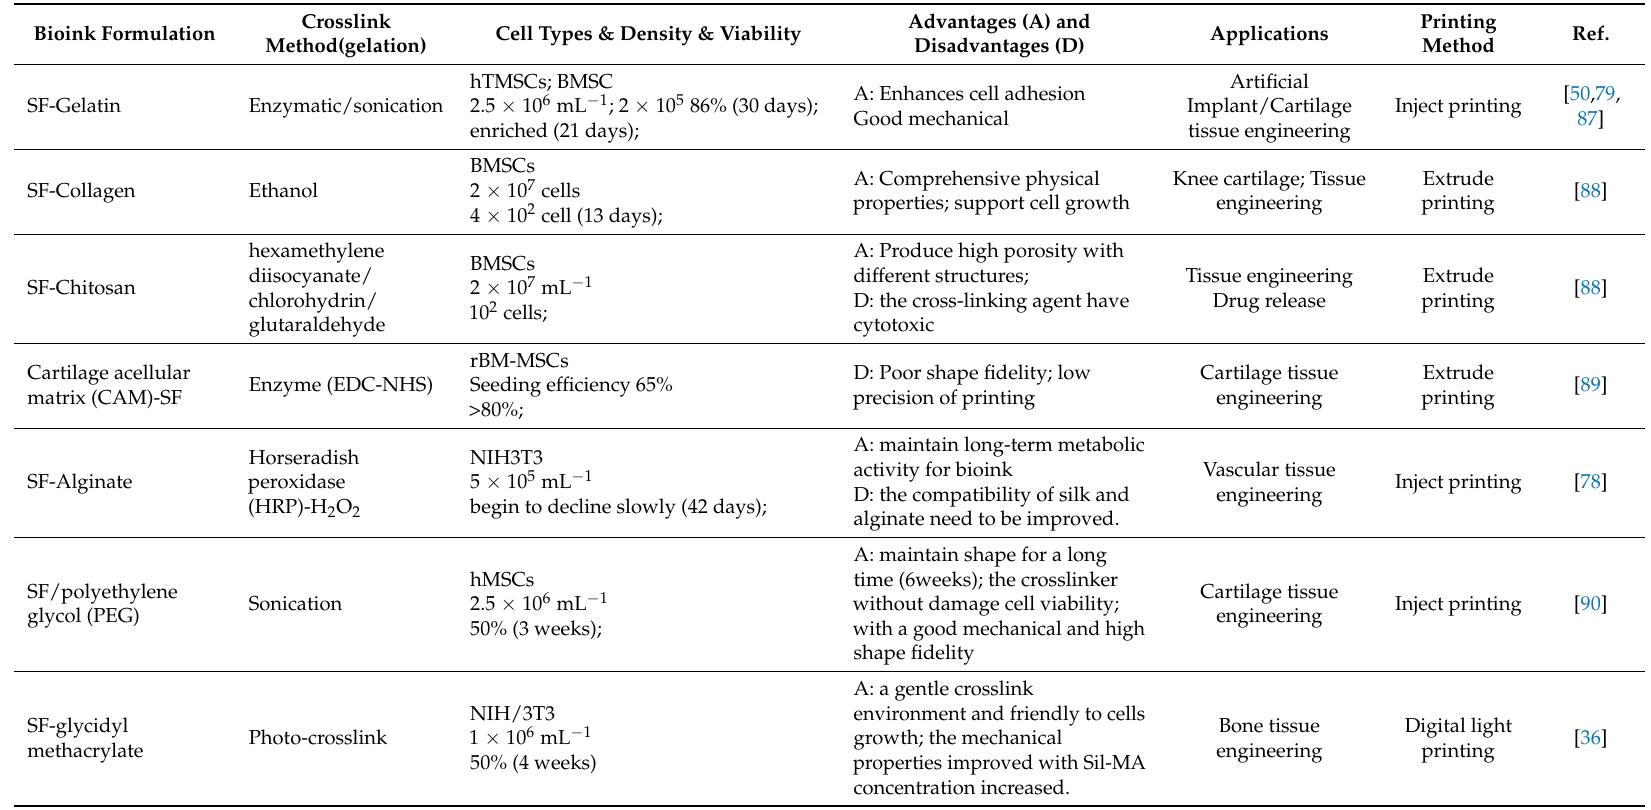
Table 2. The properties of bioink formulated by multicomponent materials based on